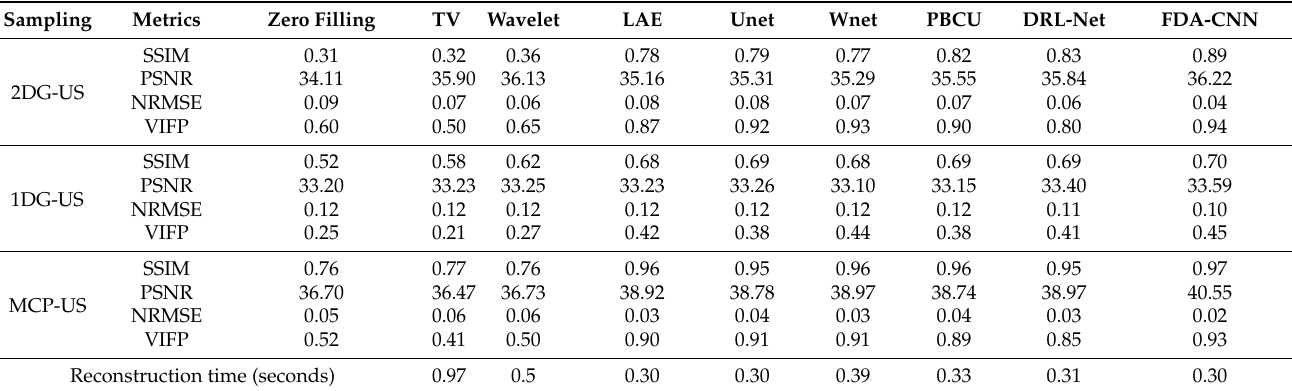
Table 1. Average SSIM, PSNR, NRMSE, and VIFP values and reconstruction time of state-of-art methods on BraTs-T1 axial brain data using several sampling